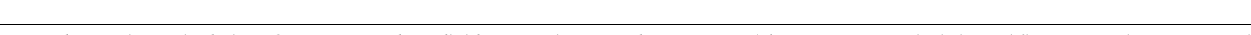
Figure 8 | Genetic manipulation of TAp63 a regulates lipid content in THLE2 hepatocytes. ( a ) Representative dual channel fluorescent photomicrograph of THLE2 cells showing staining of lipids for oleic acid (BODIPY 493/503, green) and nuclei (DAPI, blue) of THLE2 cells after the over-expression of TAp63 a or D Np63 a . Magnifications 63X. Right panel shows total lipid content (green area) ( n ¼ 4 per group). ( b ) Protein levels of TAp63 a , D Np63 a , XBP1s and FAS in THLE2 cells after the over-expression of TAp63 a or D Np63 a ( n ¼ 4 per group). ( c ) ER fragments in HepG2 cells transfected with empty plasmid control and plasmid encoding TAp63 a . ( d ) Representative dual channel fluorescent photomicrograph of THLE2 cells showing staining of lipids for oleic acid (BODIPY 493/503, green) and nuclei (DAPI, blue) of THLE2 cells cultured in oleic acid medium, treated with empty siRNA control (left image) or siRNA TAp63 a isoform (right image). Magnifications 63X. Right panel shows total lipid content (green area). ( e ) Protein levels of TAp63 a , pIKK b , XBP1s and FAS in THLE2 cells exposed to oleic acid, after treatment with siRNA against either control or TAp63 a ( n ¼ 3 per group). ( f ) Representative dual channel fluorescent photomicrograph of THLE2 cells showing staining for oleic acid (BODIPY 493/503, green) and nuclei (DAPI, blue) of THLE2 cells transfected with empty plasmid control (left image), plasmid encoding TAp63 a (middle image) and co-transfected with plasmid encoding TAp63 a and siRNA IKK b 24h after transfection (right image). Magnifications 63X. Right panel shows total TG (green area). ( g ) Protein levels of TAp63 a , pIKK b ,